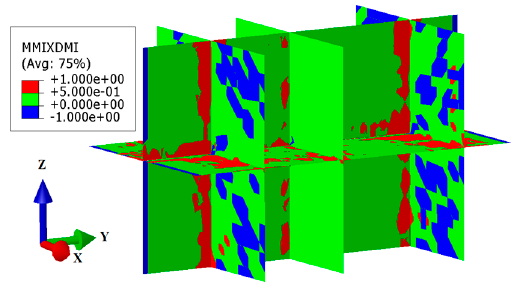
Figure 5. Fracture pattern in the model.